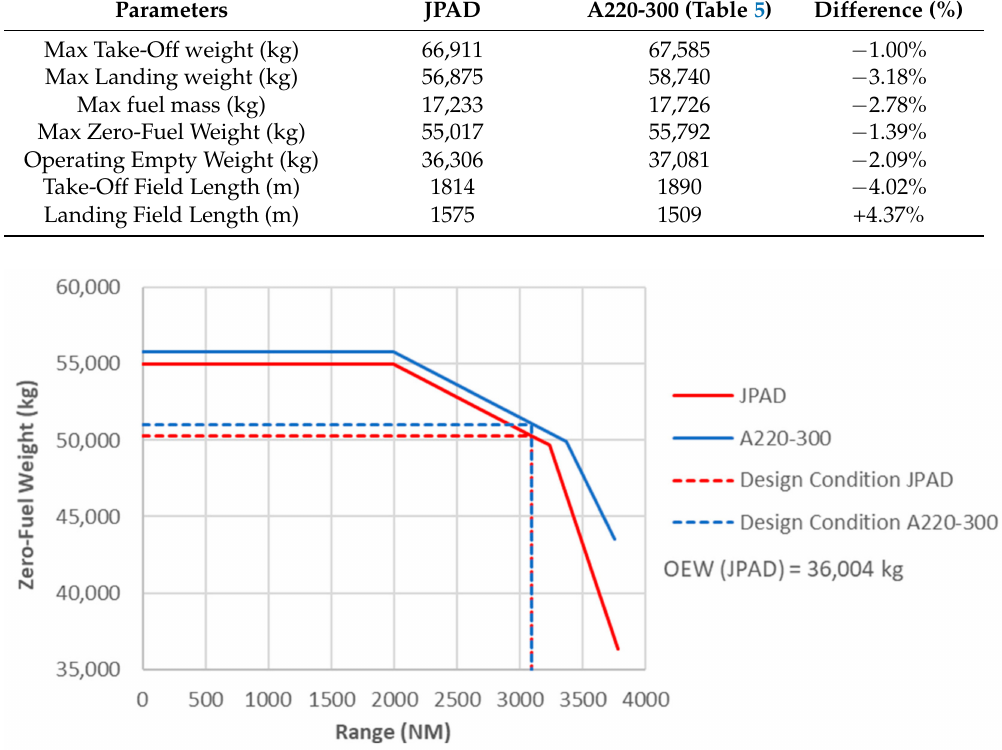
Figure 14. Payload–range chart calculated with JPAD compared with the A220-300 Payload-Range chart. Adapted from ref.